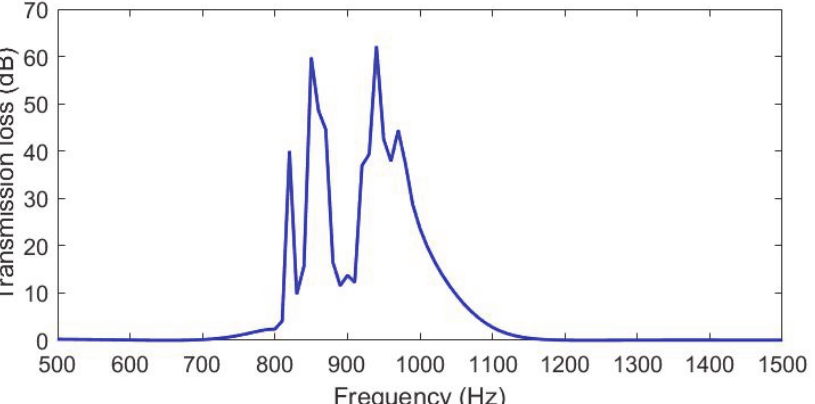
Figure 11. Acoustic analysis result of metasilencer.